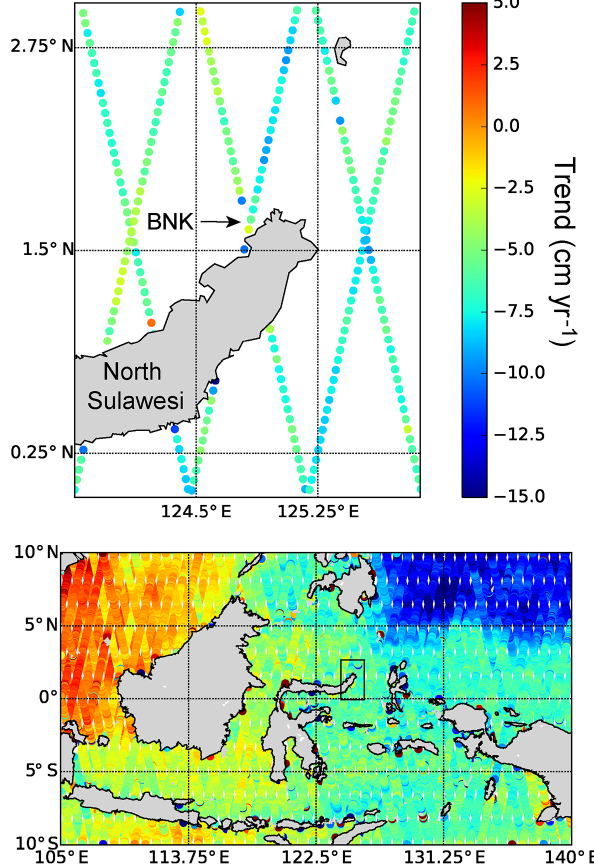
Figure 5. Top: Map of along-track SLA trend (in cmyear − 1 ) , 2013–2016, for the north Sulawesi area. The position of Bunaken Island is shown (BNK). Bottom: Map of along-track SLA trend (1Hz), 2013–2016, for Indonesia. The domain on the top panel is the rectangle in the Indonesia map of the bottom